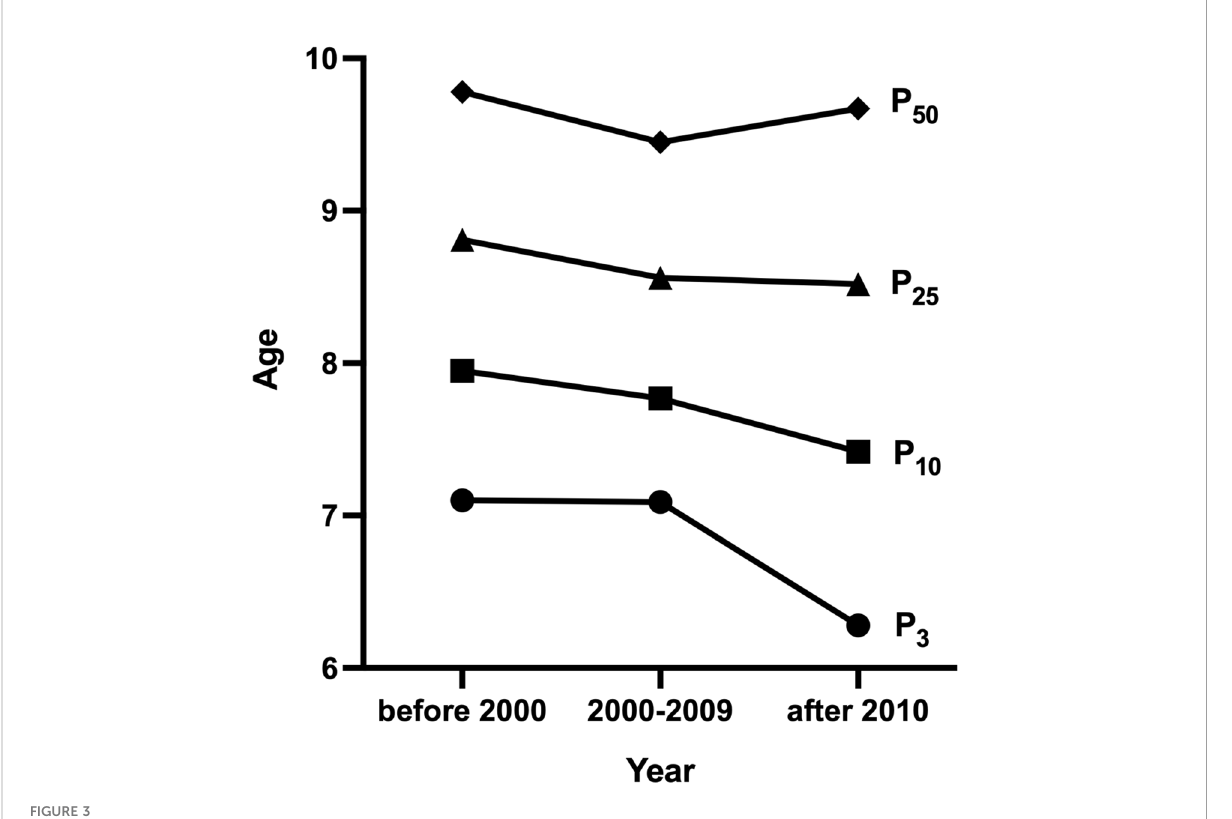
FIGURE 3 Weighted analysis of P 3 , P 10 , P 25 and median age for